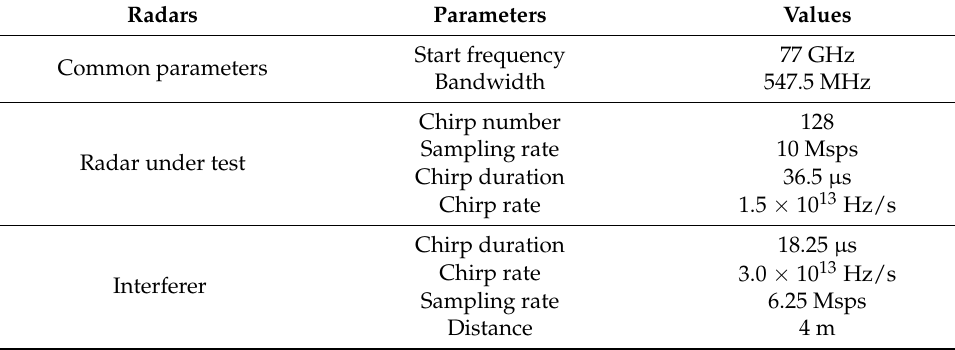
Table 3. Radar parameters used for